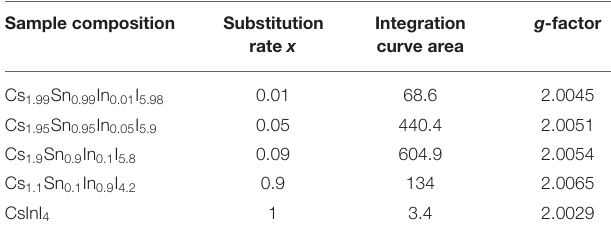
Integration rate x curve